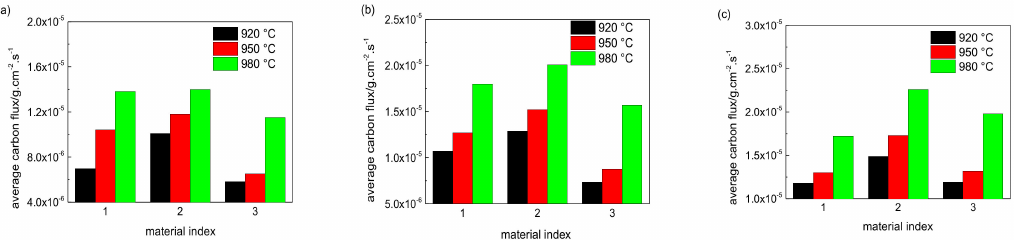
Figure 14. E ff ect of carburizing temperature on average carbon flux of three materials in 30s ( a ) 920 ◦ C; ( b ) 950 ◦ C; ( c ) 980 ◦